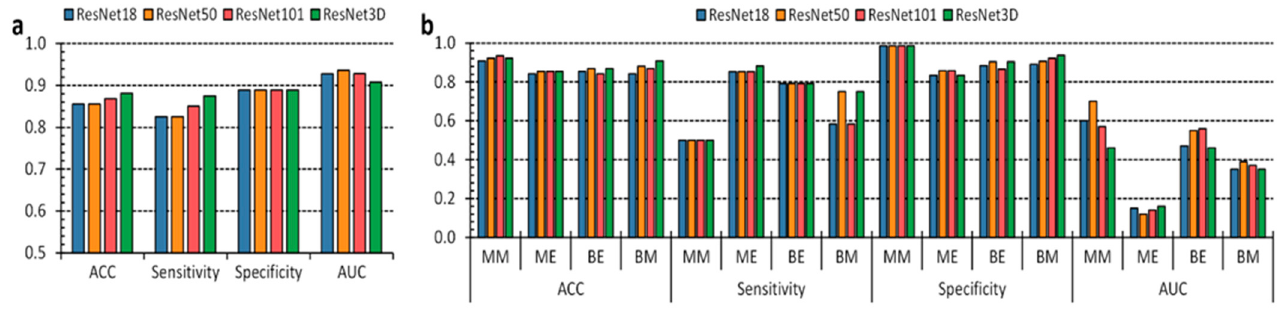
Figure 3. Performance of the epidermal lesion classification. ( a ) and ( b ), Binary and multilabel clas- sification performance of the four different approaches, respectively. performance of the four different approaches,